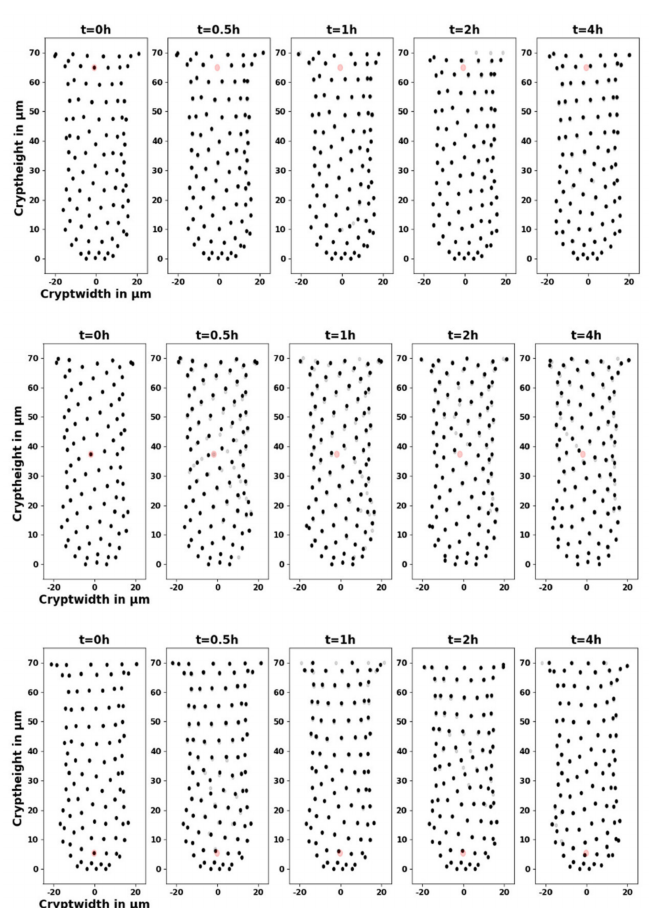
Figure A3. Simulation of cell removal in a colonic crypt zone. The simulation was performed using CHASTE [40–42], which is an agent-based simulation. We employed a previous colon crypt model in which the cell type and duration of the cell cycle are dependent on the Wnt concentration at birth. The Wnt concentration decreases linearly from the maximum value of 1.0 at the crypt base. The crypt zone ranges from 0–10 µ m, the proliferative zone from 10–40 µ m, and the differentiated zone from 40–70 µ m. The graphs show the cell movement after ablation of a cell in the three relevant crypt areas. The individual cells are shown as black dots, the gray dots are the cell positions from the previous time point, and the red dots show the position of the cells that are ablated at the first time point. In all cases, neighboring cells enter the ablation